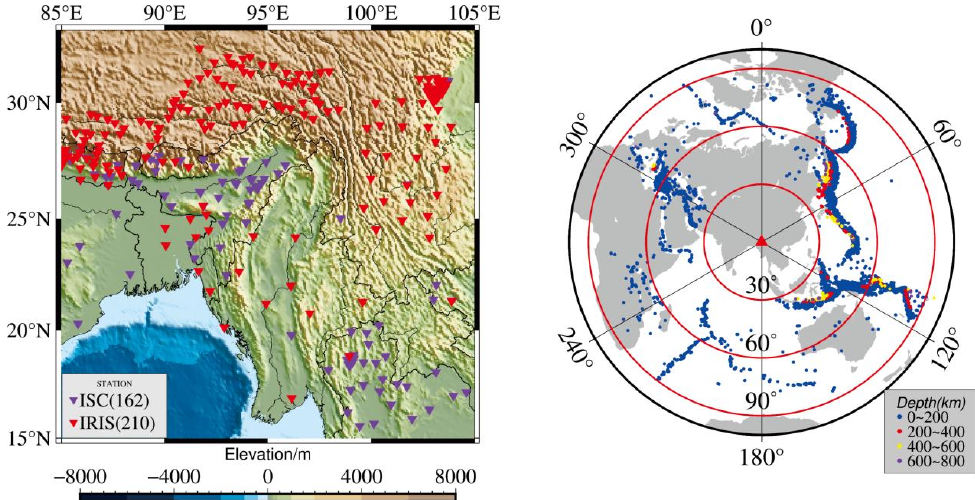
Figure 2. Stations and teleseismic events received by the stations in this article. The left picture is the branch of the station in the study area, and the right picture is the epicenter distribution of teleseismic events.